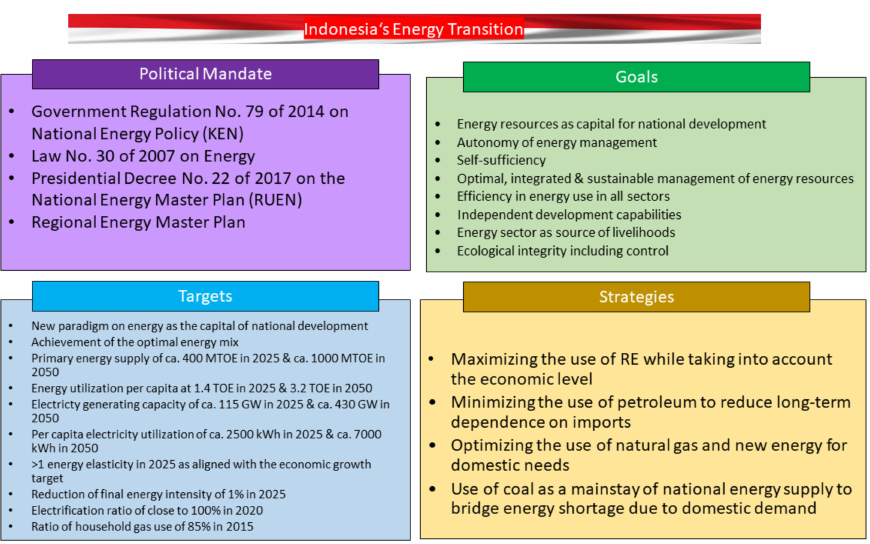
Figure 2. Indonesia’s Energy Transition in a Nutshell (own